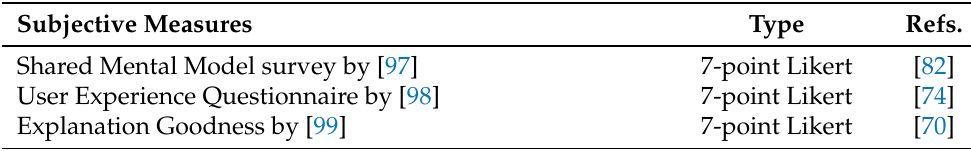
Table 2. Measurements used to assess transparency of a system and understanding thereof in current research. The list does not include papers that do not provide concrete wording (e.g.,